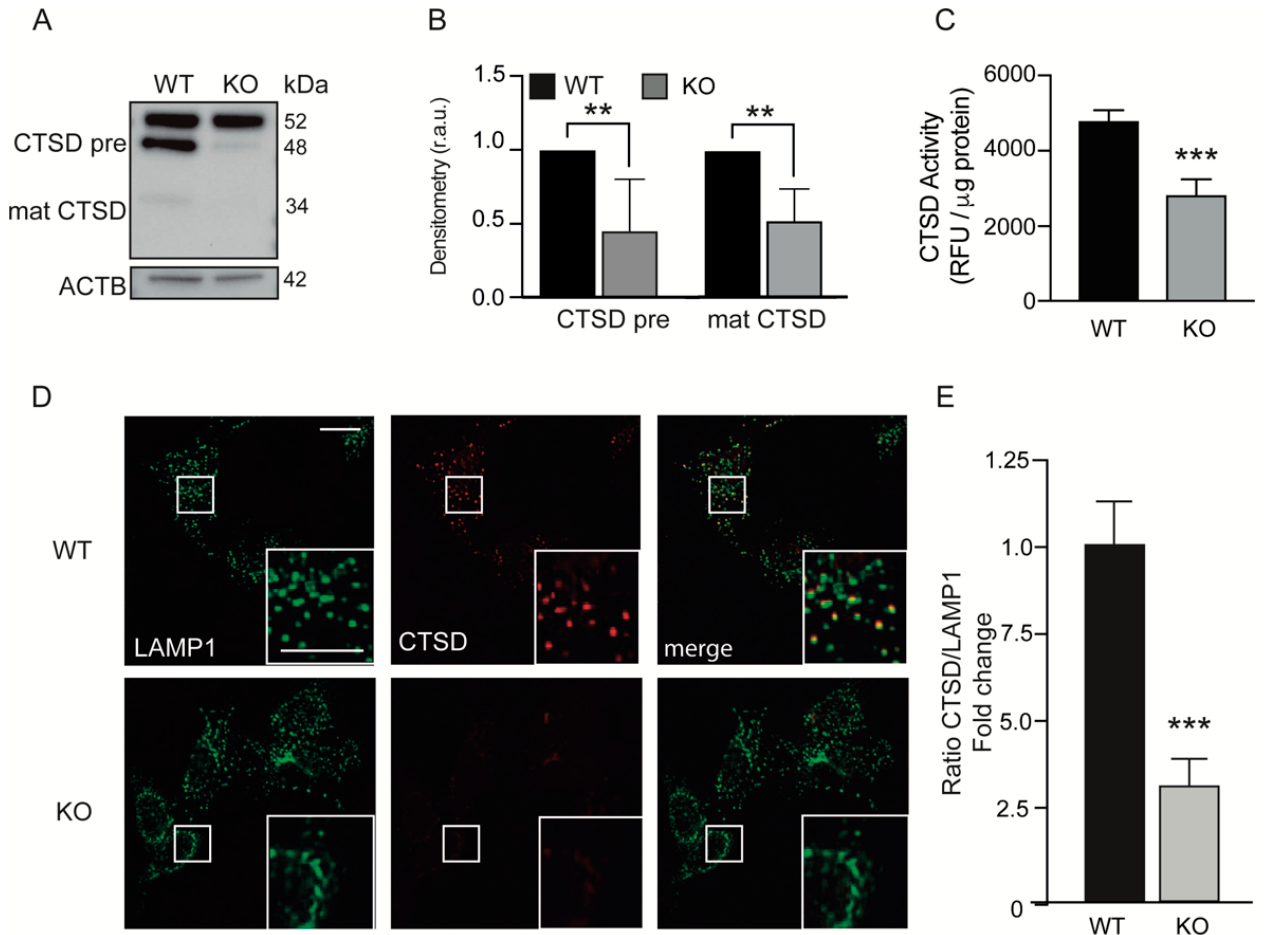
Figure 3. KEAP1-deficient cells show LAMP1-labeled vesicles with reduced CTSD activity. ( A ) Cell lysates from WT and Keap1 KO MEFs were analyzed with Western blotting using anti-CSTD antibody. ACTB was used as a loading control. ( B ) Densitometry was employed to quantify the abundance of different isoforms of CTSD normalized to ACTB (** p < 0.01 vs. WT cells). ( C ) The graph shows the CTSD activity in relative fluorescence units (r.f.u.) per microgram of proteins (*** p < 0.001 vs. WT cells). ( D ) Representative immunofluorescence images of cells costained with LAMP1 and CTSD. The scale bar represents 10 µm. ( E ) The graph shows the ratio of CTSD/LAMP1 (*** p < 0.001 vs. WT cells). All data are the means ± SD of at least three independent experiments and they were analyzed using Student’s t -test.